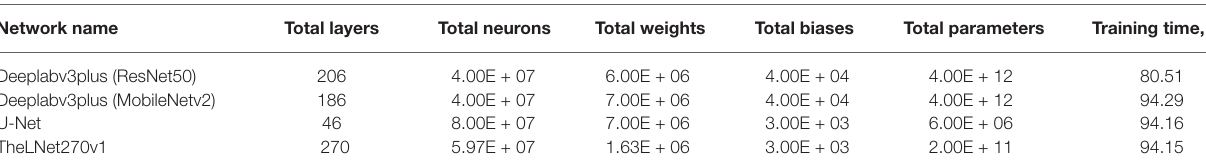
TABLE 9 | Comparative statistics of the various network architectures. Network name